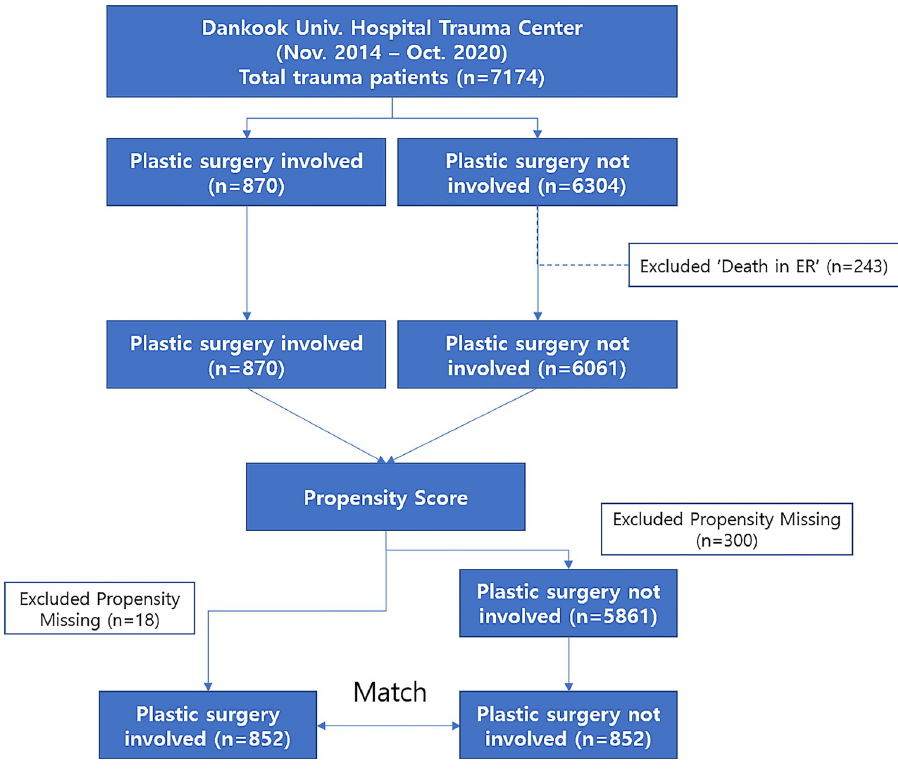
Fig 1. Algorithm of study